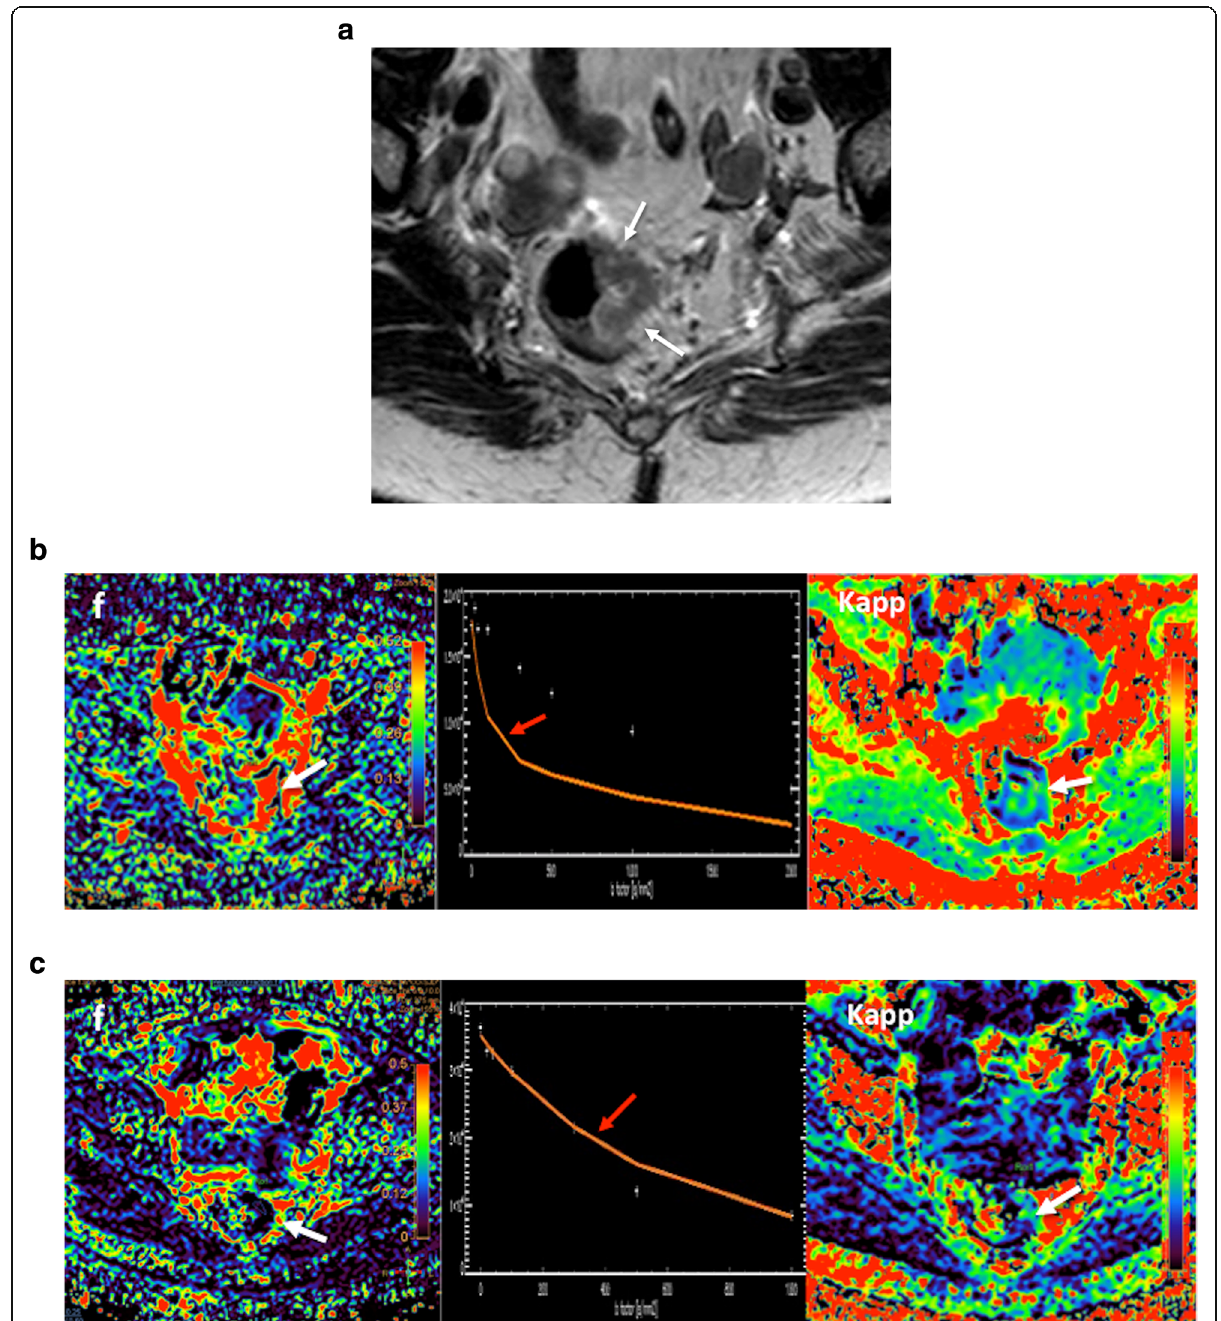
Fig. 4 Rectal cancer in a 65-year-old woman. a Axial T2-weighted image demonstrated a rectal mass deeply extending to the mesorectal fat (white arrow). b Perfusion fraction ( f ), apparent kurtosis diffusion (Kapp), and the curve of signal intensity decay in diffusion pretherapy. Note that this curve showed a marked attenuation of signal intensity at low b values (red arrow) due to the influence of tumor perfusion on diffusion. c Following therapy, there are reduction of both f and Kapp and dissapearance of the fast attenuation of the signal intensity at low b values, related to tumor response with reducer perfusion on IVIM